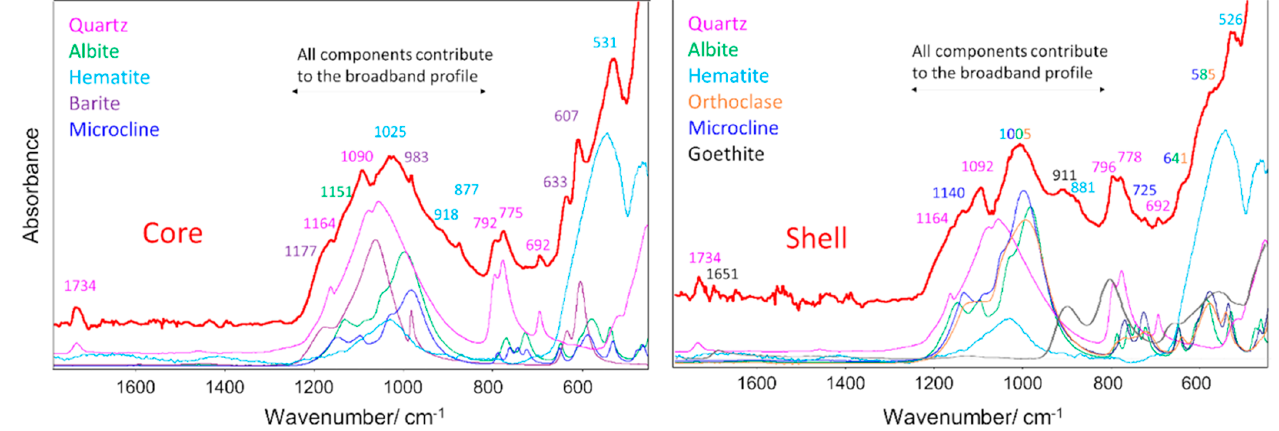
Figure 10. Assignment of the IR (ATR) spectra of the core ( left ) and shell ( right ) compartments of the studied fulgurite (red spectrum). In the region around 900–1200 cm − 1 , glassy SiO 2 material also contributes to the intensity [36].